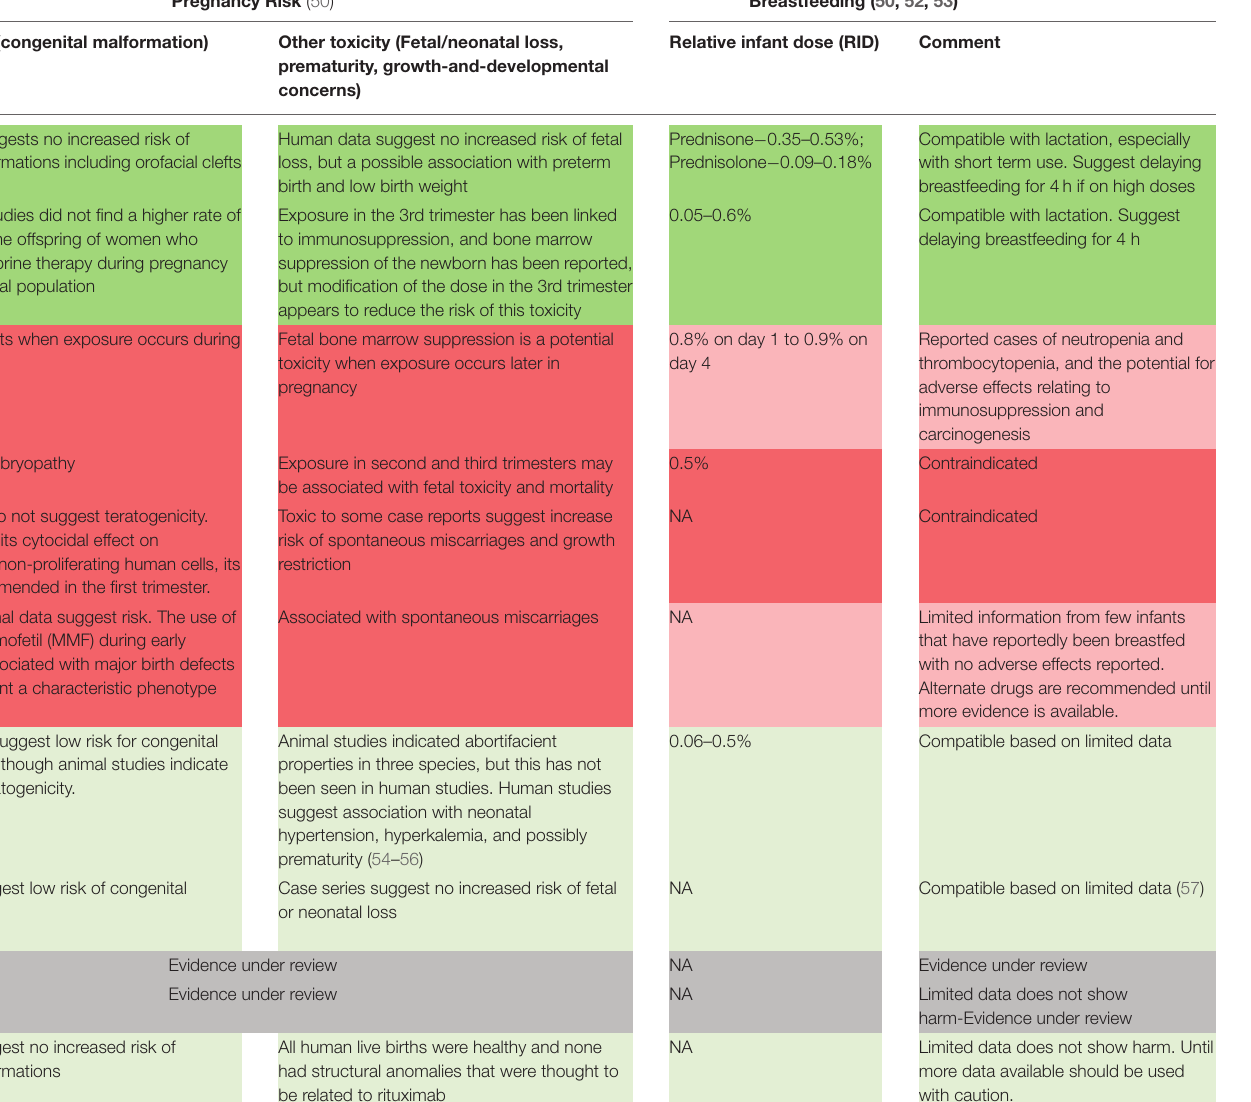
TABLE 2 | Therapeutic recommendations for Neuromyelitis Optica Spectrum Disorder patients during pregnancy and breastfeeding.